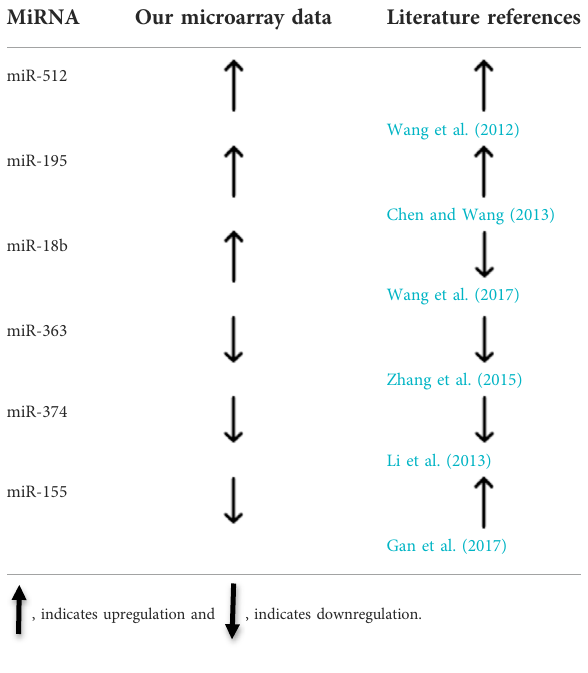
TABLE 3 Selected miRNAs from our microarray data along with their literature